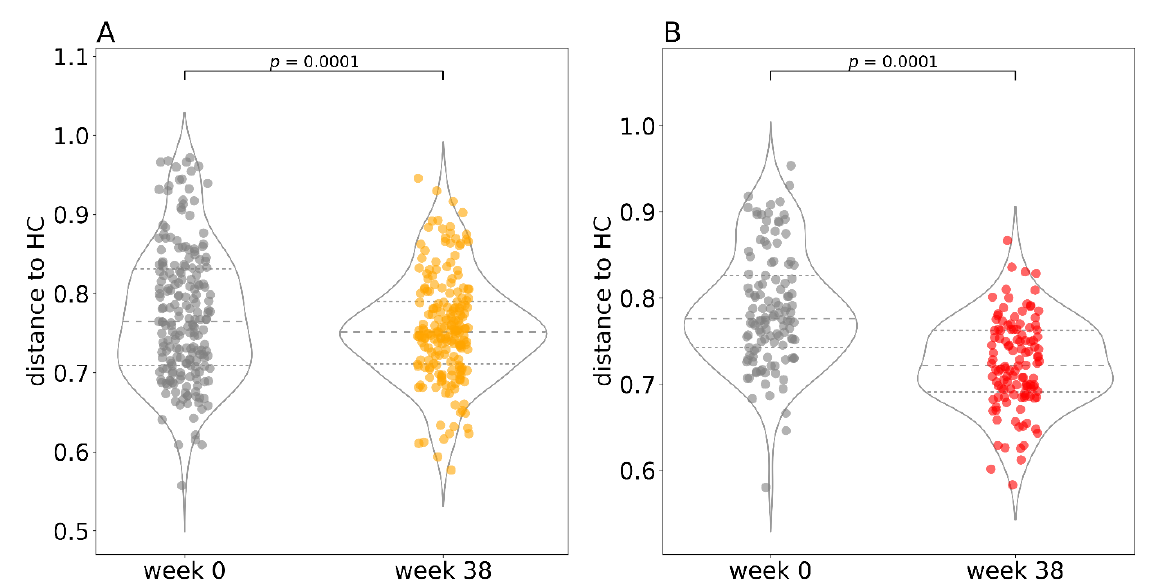
Figure 6. Distance to healthy controls at the beginning and at the end of therapy. A visual representation of the restricted permutation design with Bray–Curtis distance to healthy controls at the beginning (week 0) and at the end (week 38) of the study for Crohn’s disease ( A ) and ulcerative colitis ( B ) separately. In the violin plots, the middle dashed line represents the median and the outer dashed lines represent the first and third quartiles. Each dot in the superimposed strip plot represents a single distance from a patient at baseline (week 0) to a healthy control at baseline or a single distance from a patient at the endpoint (week 38) to a healthy control at the endpoint. Abbreviations: HC, healthy controls.